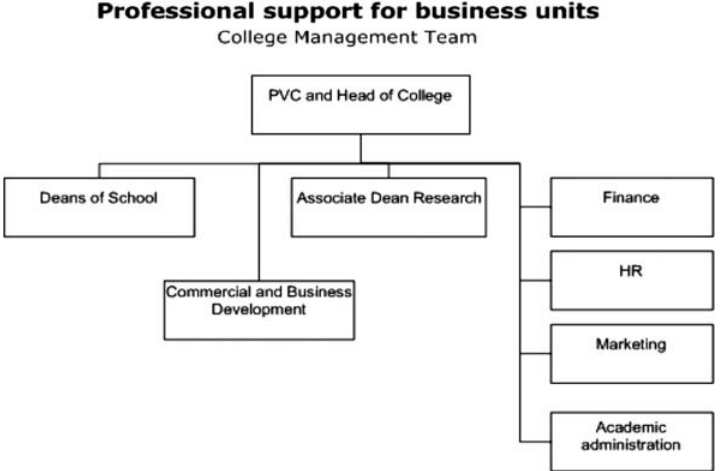
Figure 2. College management